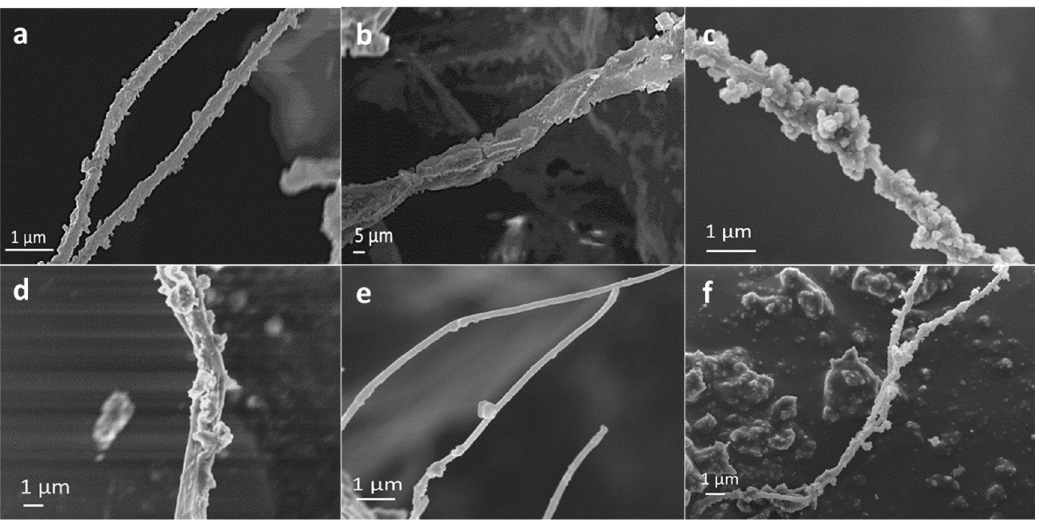
Figure 1. VPSEM micrographs of some selected mineralized fibrils of Table 1: a ) Col/Ap, b ) cit high –